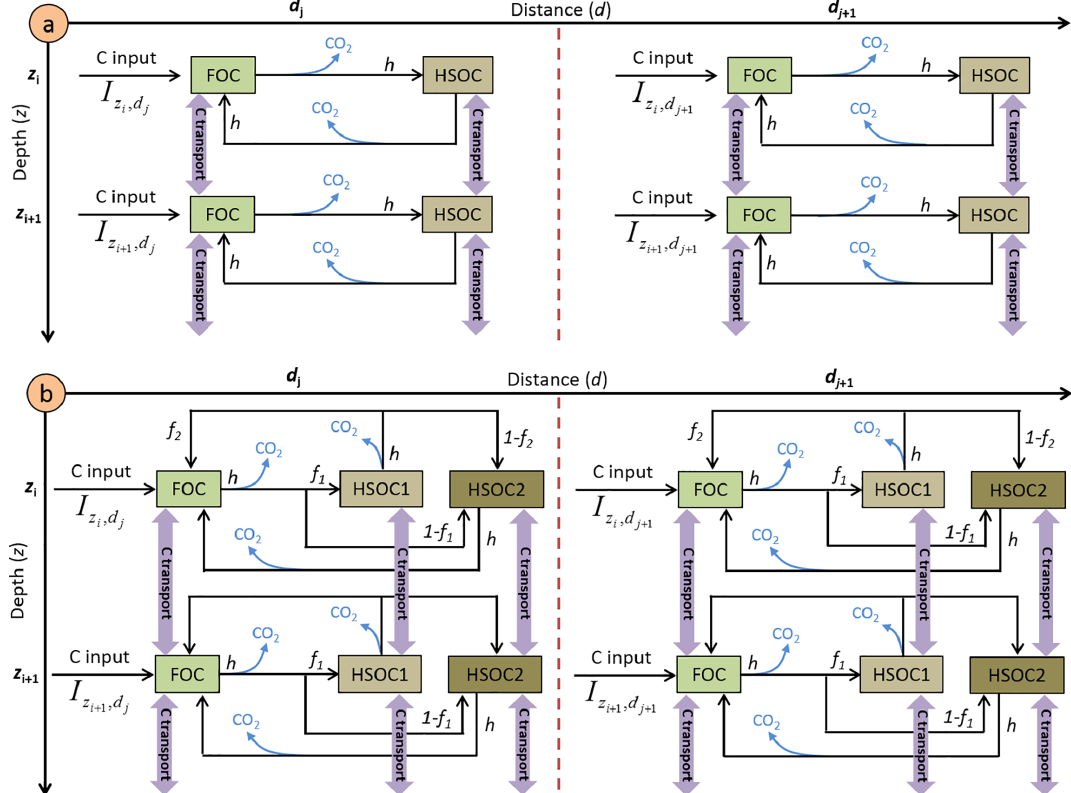
Figure 2. Schematic representation of the pools and the fluxes of the (a) two-pool model and (b) three-pool